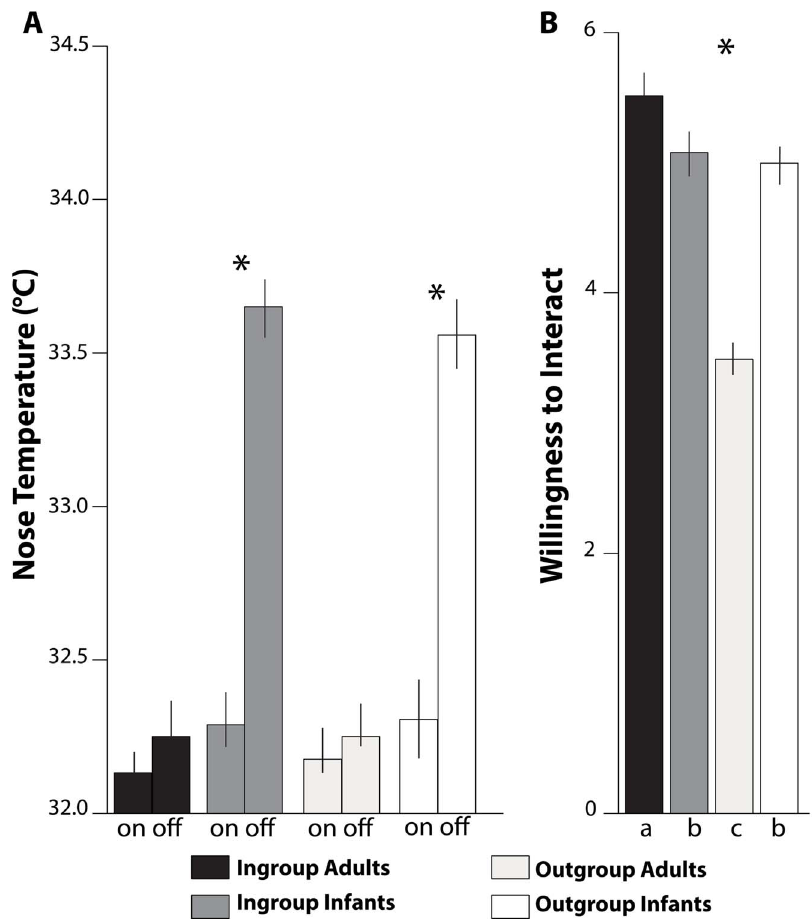
Figure 4. Japanese and Italian participants merged. Responses to the presentation of the faces of Ingroup adults (black), Ingroup infants (dark grey), Outgroup adults (light grey), and Outgroup infants (white). (A) Mean levels ( 6 SEM) of the tip of the nose temperature at onset (on) and offset (off) of picture presentation. (B) Mean levels ( 6 SEM) of scores for Willingness to Interact with the person. Bars with different subscripts (a, b, and c) are significantly different in Tukey HSD post-hoc tests.